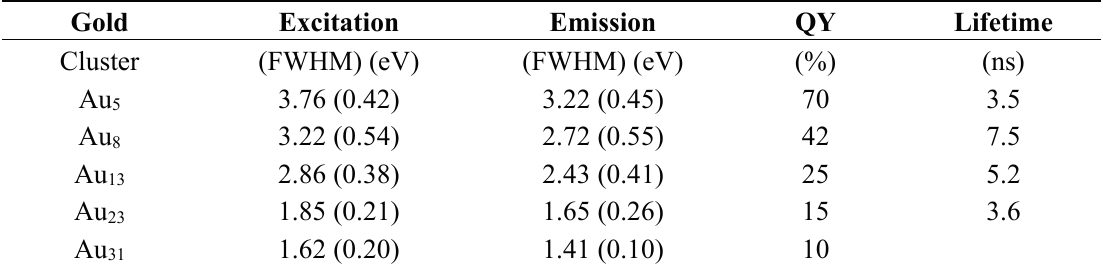
Table 2. Measured PAMAM templated Au-NC photophysical properties